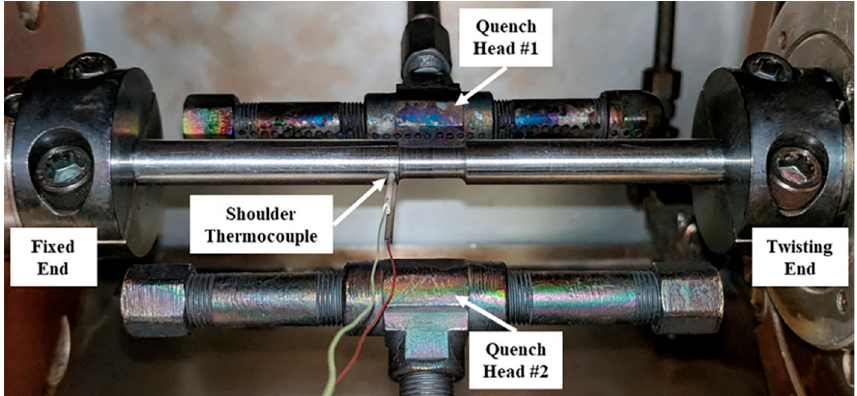
Figure 5. Photograph inside the Gleeble ® 3500 Hot Torsion Mobile Conversion Unit chamber highlighting the hot torsion setup. The shoulder thermocouple was required to control temperature during accelerated cooling and isothermal holding.